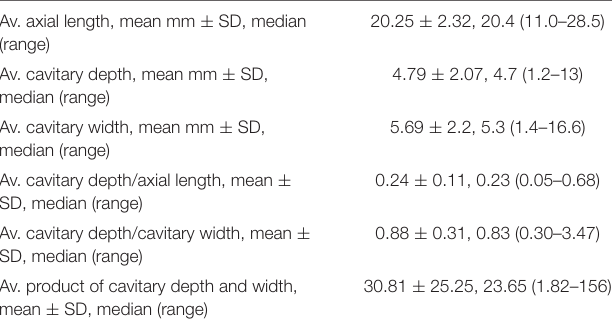
TABLE 3 | Echographic characteristics of MGDA in this study ( n = 271).